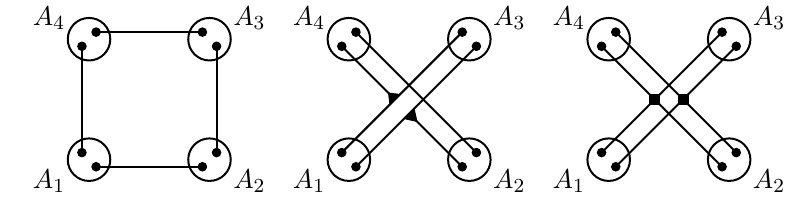
Figure 8 . We provide a graph representation of the various terms contributing to I 4 . Single lines represent two-point correlators, lines converging at a triangle vertex represent three-point correlators while lines converging at a square vertex represents connected four-point correlators. Observe that each diagram gives a completely connected contribution to I 4